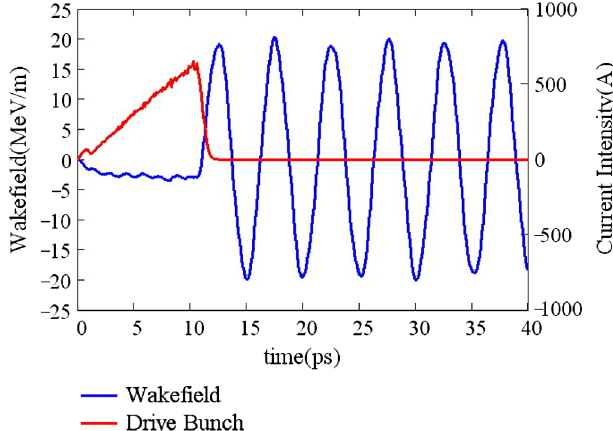
FIG. 9. Current profile of the shaped drive bunch shown in Fig. 5(b) and its excited wakefield in the DWA with parameters shown in Table